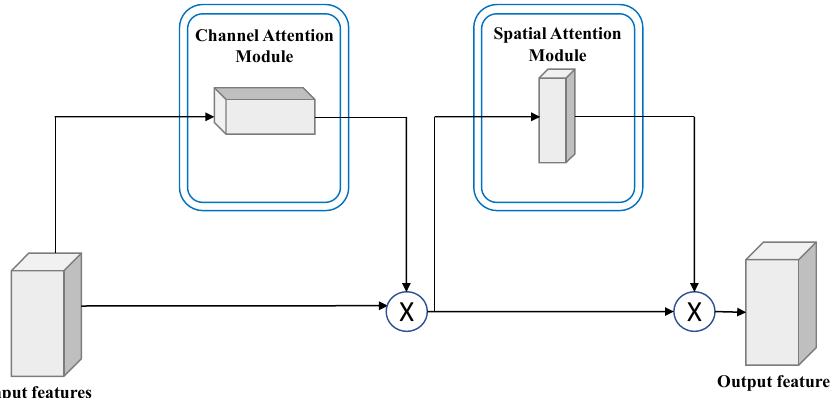
Figure 5. Convolutional block attention module (CBAM) block. It consists of channel and spatial attention modules. The feature maps from the encoding layers are refined through the CBAM block.